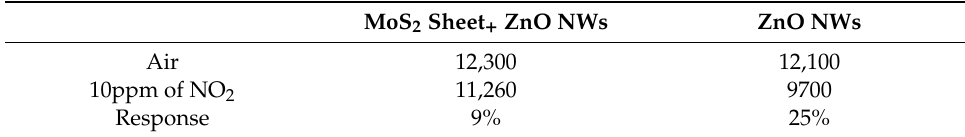
Table 2. Value of PL as peak area (from 380 nm to 410 nm) in air and in 10 ppm of NO 2 and corresponding response (relative change of peak area) over the MoS 2 sheet+ZnO NWs region in Figure 5 and immediately outside over the ZnO NWs.